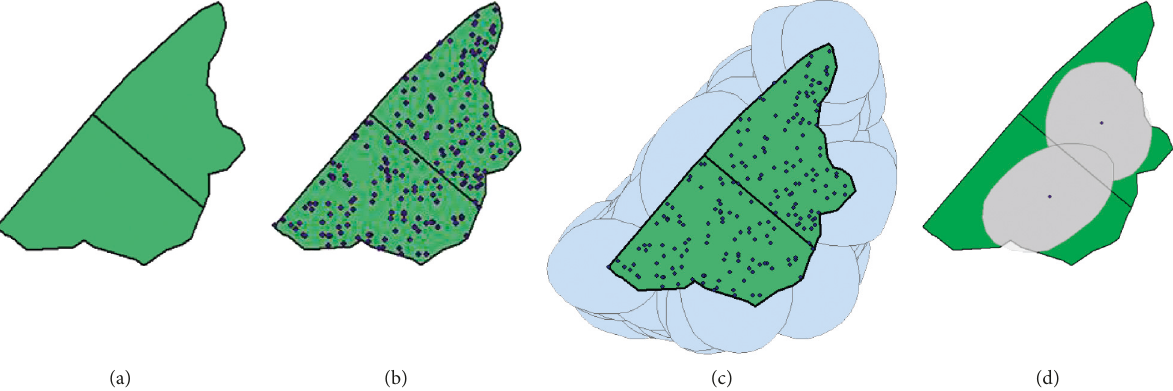
Figure 5: Obtainment of critical slip surface of slope units: (a) slope unit division; (b) center points of ellipsoids; (c) trial slip surfaces; (d) the most dangerous slip surface.